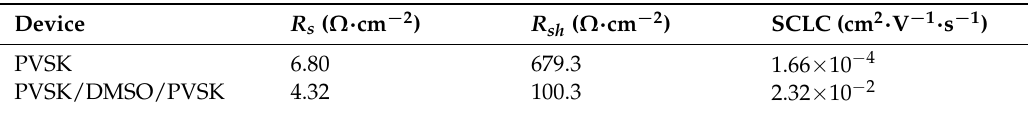
Table 2. SCLC data, R s and R Sh of perovskite device on a pristine PEDOT:PSS film (PVSK) and PEDOT:PSS films on PEDOT:PSS film with the perovskite layer washed away by DMSO (PVSK/DMSO/PVSK).